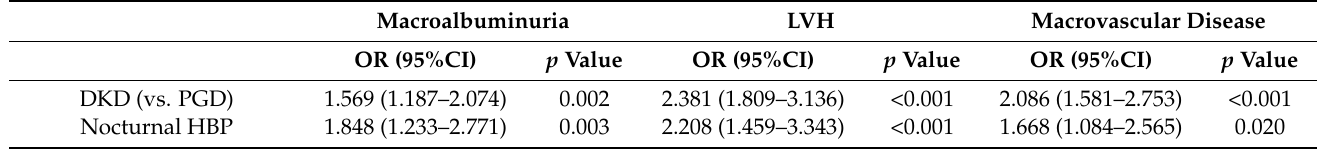
Table 4. Association between different groups, nocturnal hypertension (Yes/No) and target-organ damage using multivariate logistic regression analysis ( n =